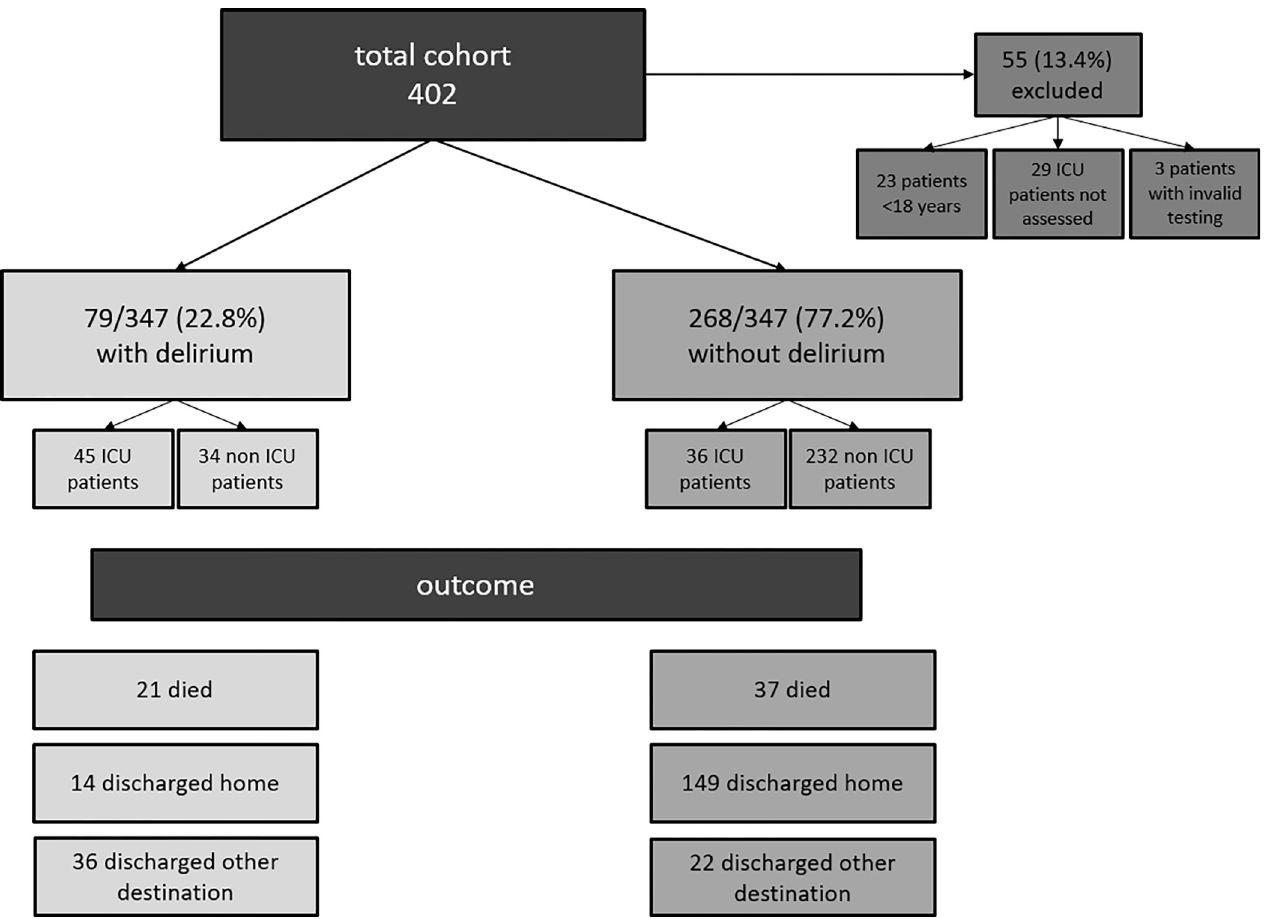
Fig 1. Incidence of delirium and mortality in the study